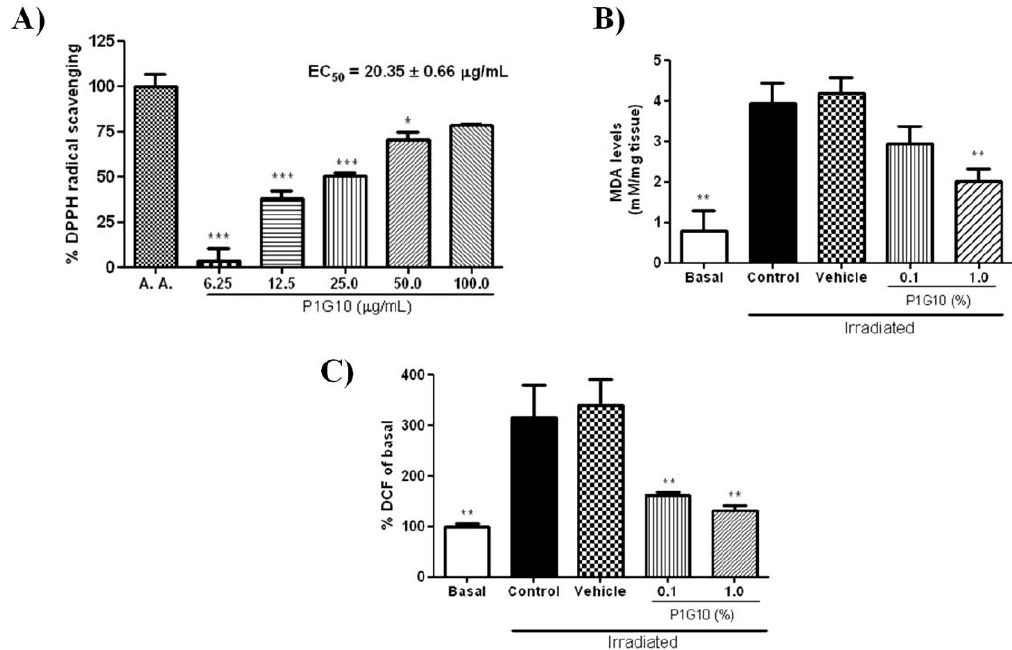
Figure 8. The e ff ect of P1G10 on mediators of oxidative stress in UVB-irradiated skin. Mice were exposed to UVB (2.4 J cm − 1 ) and treated with Natrosol gel (vehicle) or 0.1% and 1% P1G10. After 24 h, the skin of euthanized animals was dissected and processed for analysis. ( A ) Antioxidant activity measured by DPPH assay. ( B ) Content of malondialdehyde (MDA); ( C ) production of dichlorofluorescein (DCF). For details see the Materials and Methods. Data are expressed as mean ± SEM of 6–8 animals per group (* p < 0.05, ** p < 0.01, *** p < 0.001 di ff erences versus Vehicle, ANOVA, Newman–Keuls